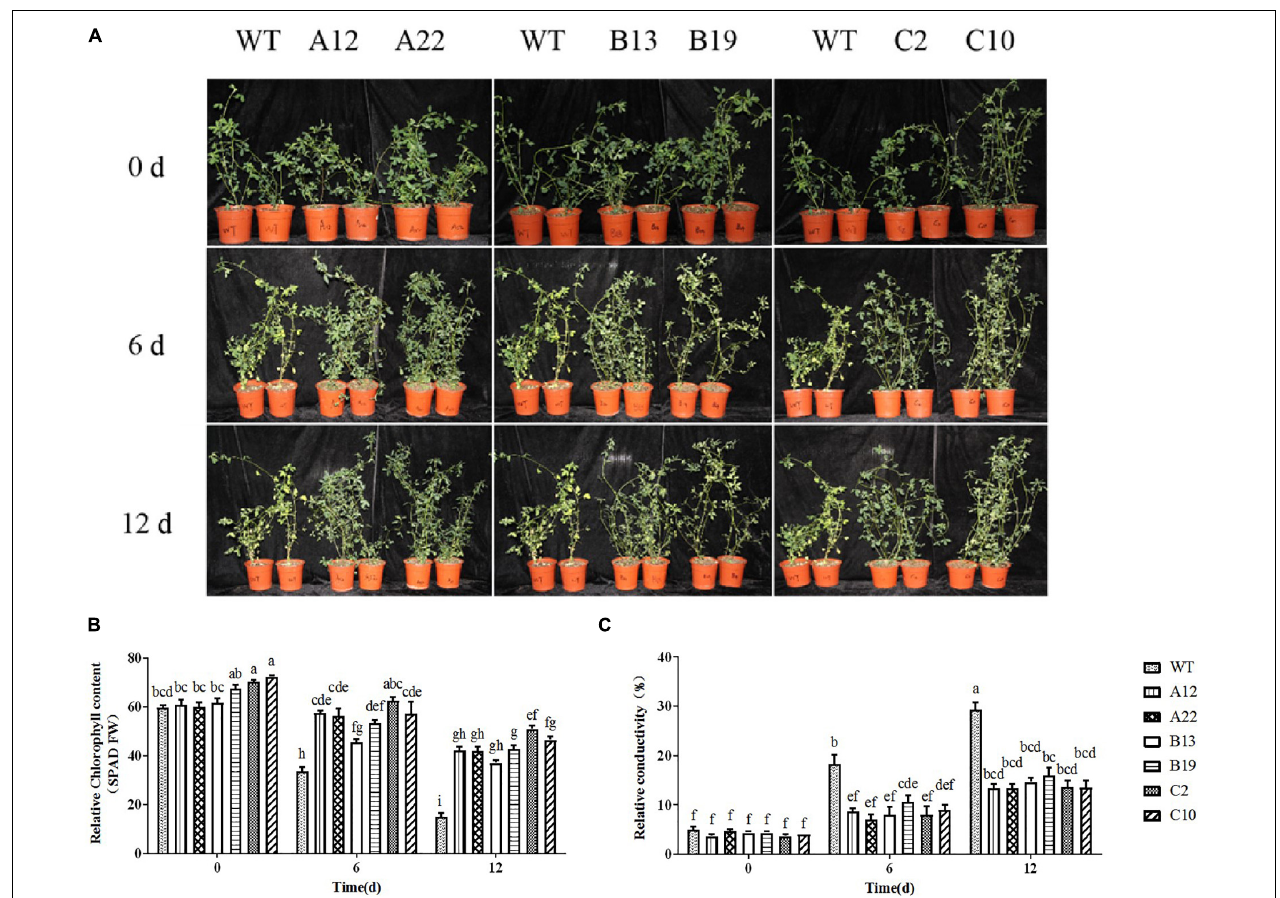
FIGURE 2 | Phenotype (A) , Chl content (B) , and relative conductivity (C) analysis of MsRCI2 transgenic alfalfa plants under alkali stress. WT stands for wild-type; A12 and A22, B13 and B19, and C2 and C10 were transformed with the MsRCI2A , MsRCI2B , MsRCI2C genes, respectively. The values are the means ± SDs of three replicates (Duncan test: P <